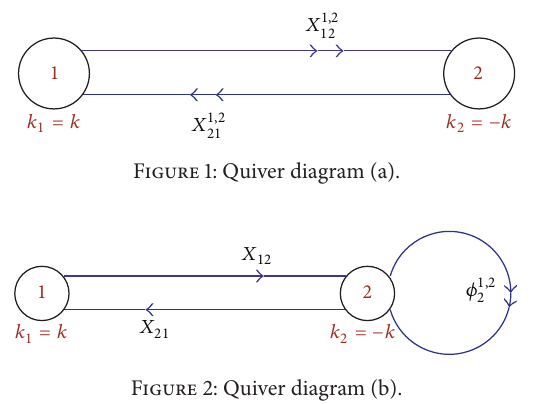
Figure 2: Quiver diagram